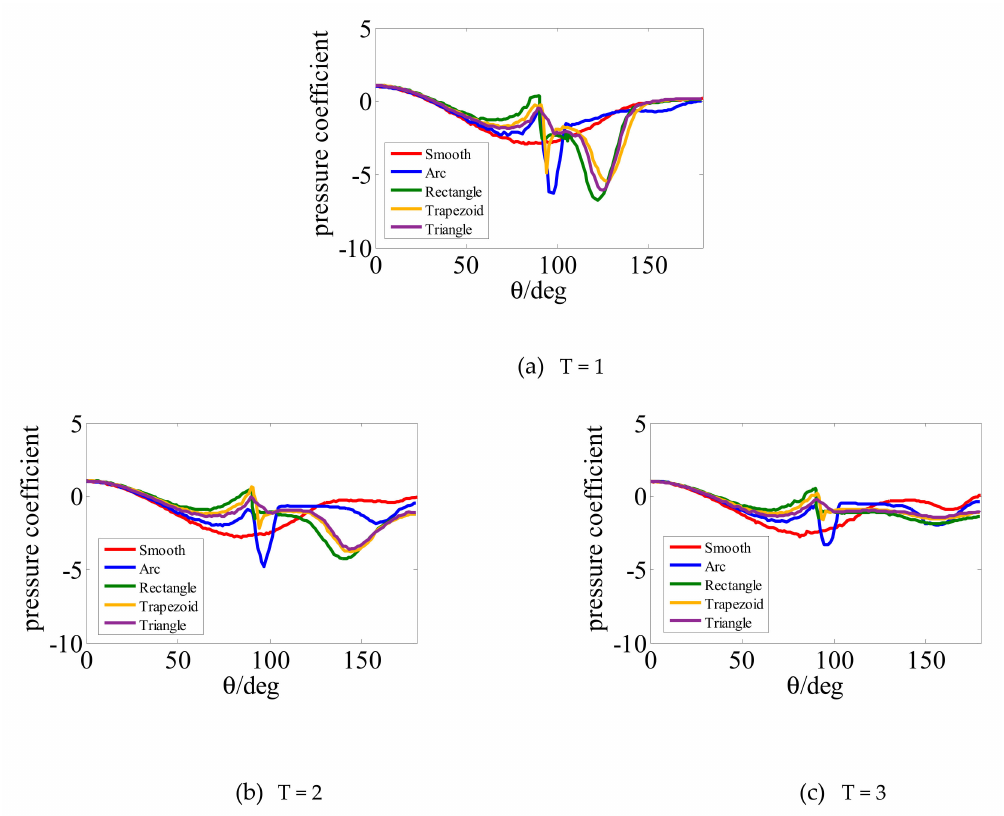
Figure 15. The comparison of the pressure coe ffi cient between the smooth cylinder and cylinder with strips of di ff erent shapes for Re =